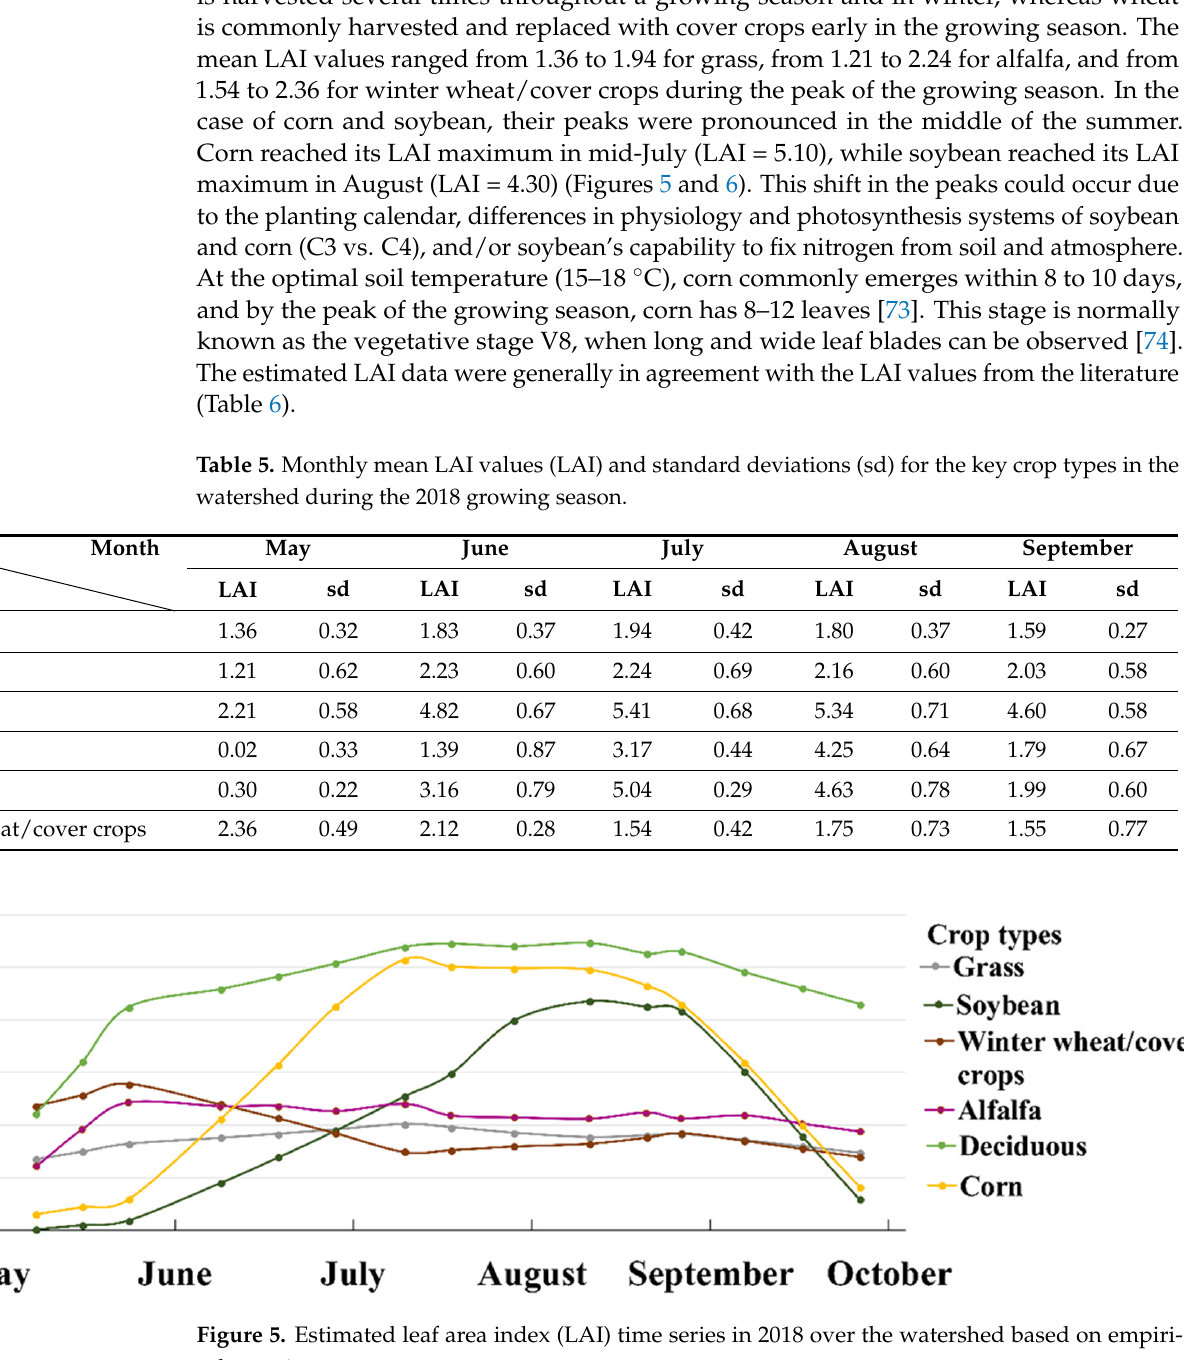
Figure 6. Estimated leaf area index (LAI) for each key crop (10-day averaged values) during the 2018 growing season.